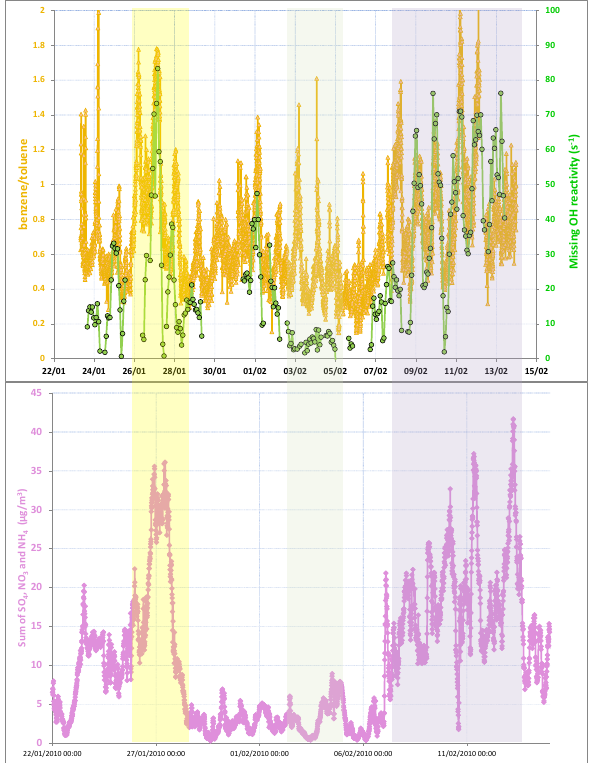
Fig. 13. Top panel: Benzene/Toluene ratio and Missing OH reactiv- ity; bottom panel: sum of SO 4 , NO 3 toluene and NH 4 Figure 1213. Top panel: Benzene/Toluen ratio and Missing OH reactivity; Bottom panel: sum of 3 SO 4 , NO 3 and NH 4 4